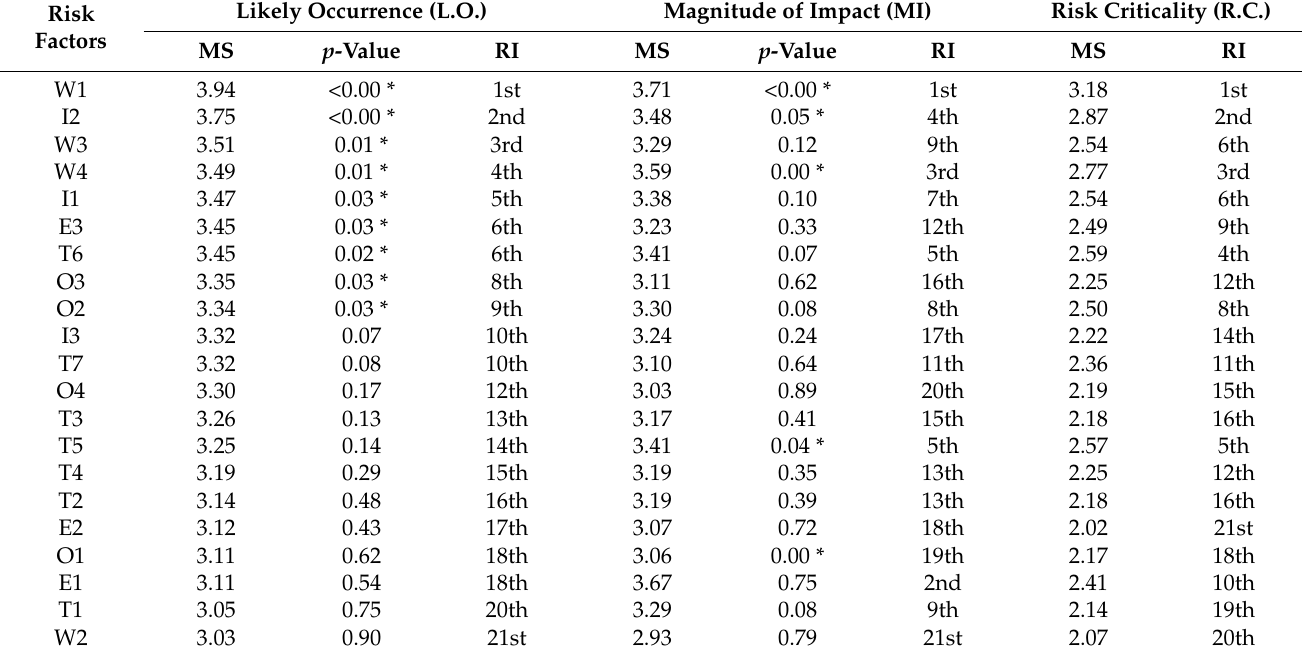
Table 4. Risk factors preventing organizations from implementing ImTs ( n =